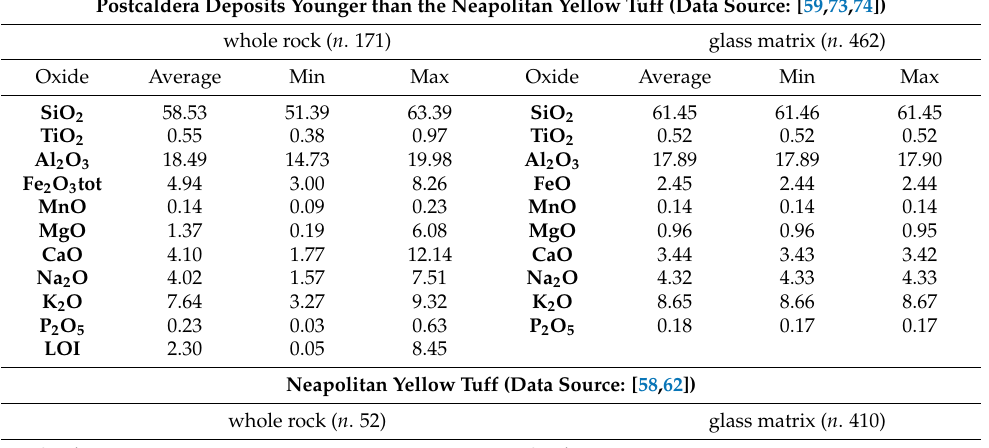
Table 2. The chemistry of protolith rocks forming the geothermal reservoirs at San Vito 1. Rocks are grouped considering the initial reservoir stratigraphy in Section